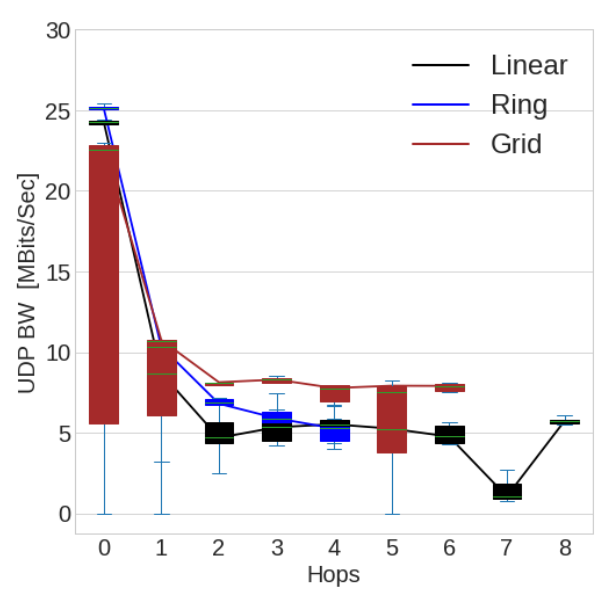
Figure 24. W-iLab2.t UDP